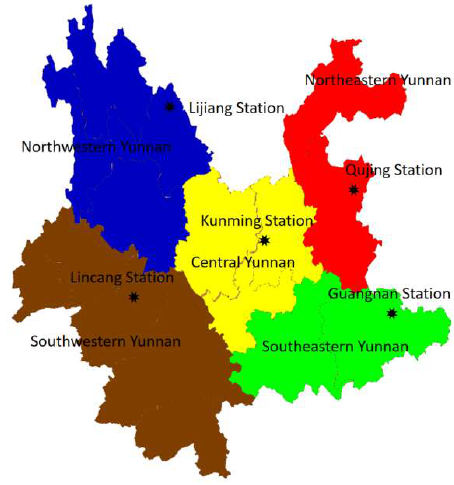
Figure 1. Yunnan research site.